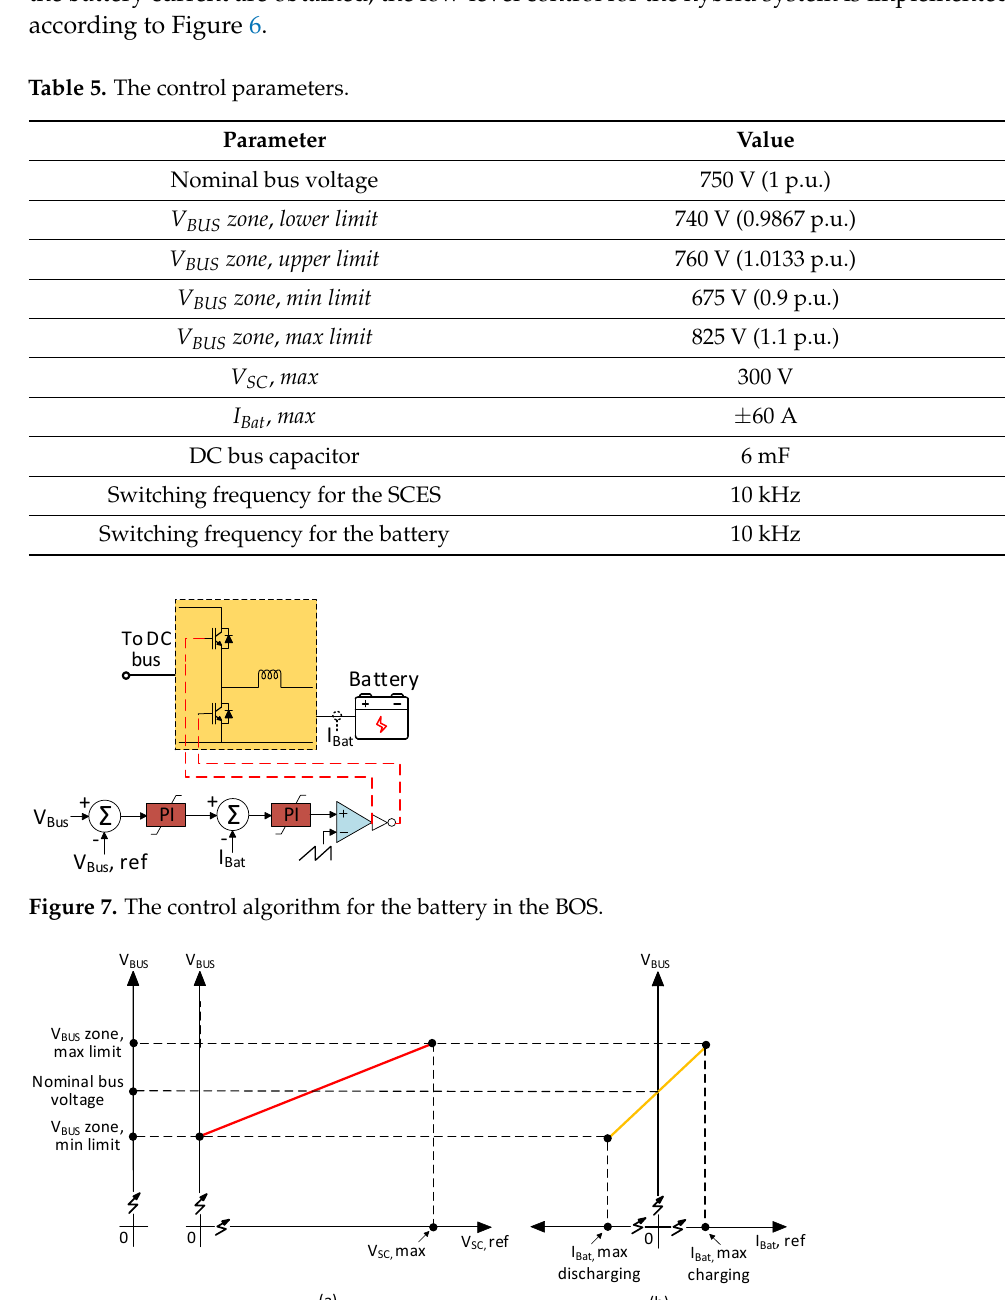
Table 5. The control parameters.